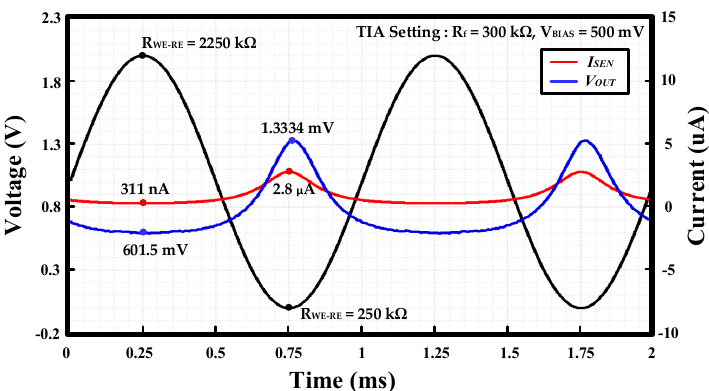
Figure 11. Output voltage simulation results of the current mirror and TIA.